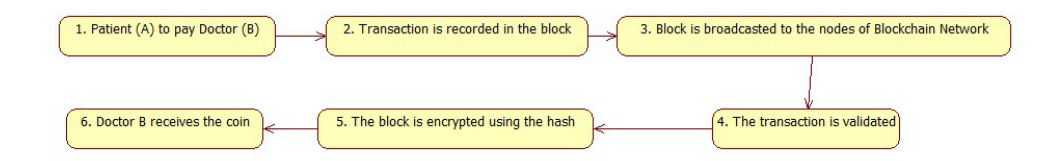
Figure 3. State machine diagram for patient transactions execution on a blockchain.